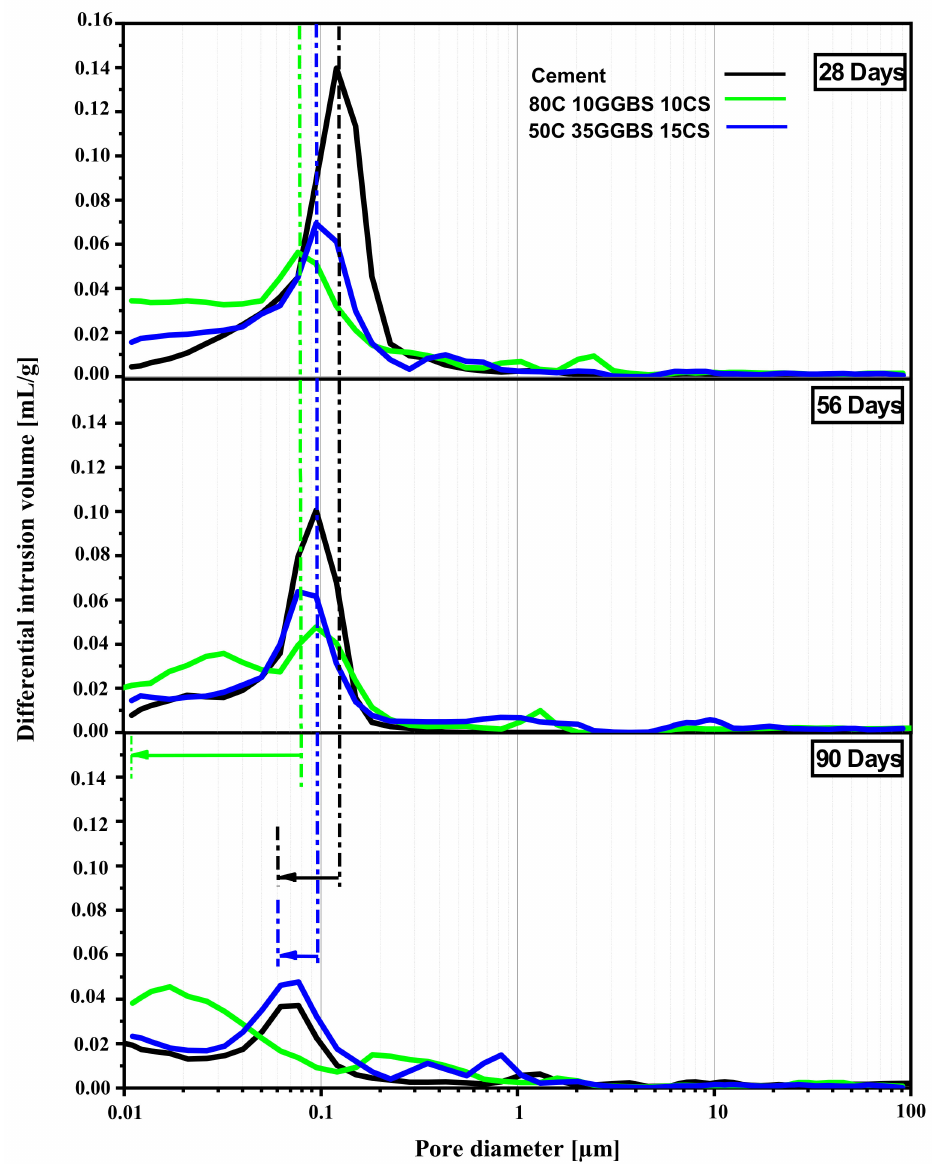
Figure 13. Mix pore size structures after 28, 56, and 90 days of curing. The classification of porosity according to the diameter of the pores makes it possible to distinguish four types of porosity: harmless porosity (<20 nm), less harmful porosity (20–50 nm), harmful porosity (20–50 nm), and more harmful porosity (>200 nm) [46]. This classification is an indication of the durability of the mix. Figure 14 shows an increase in the harmful porosities for the control mix with the curing age, compared to those containing GGBS and CS. Moreover, there is an increase in harmless porosity for mixes containing GGBS and CS, which can be attributed to the effect of their pozzolanic activities. These results correlate well with those related to mechanical